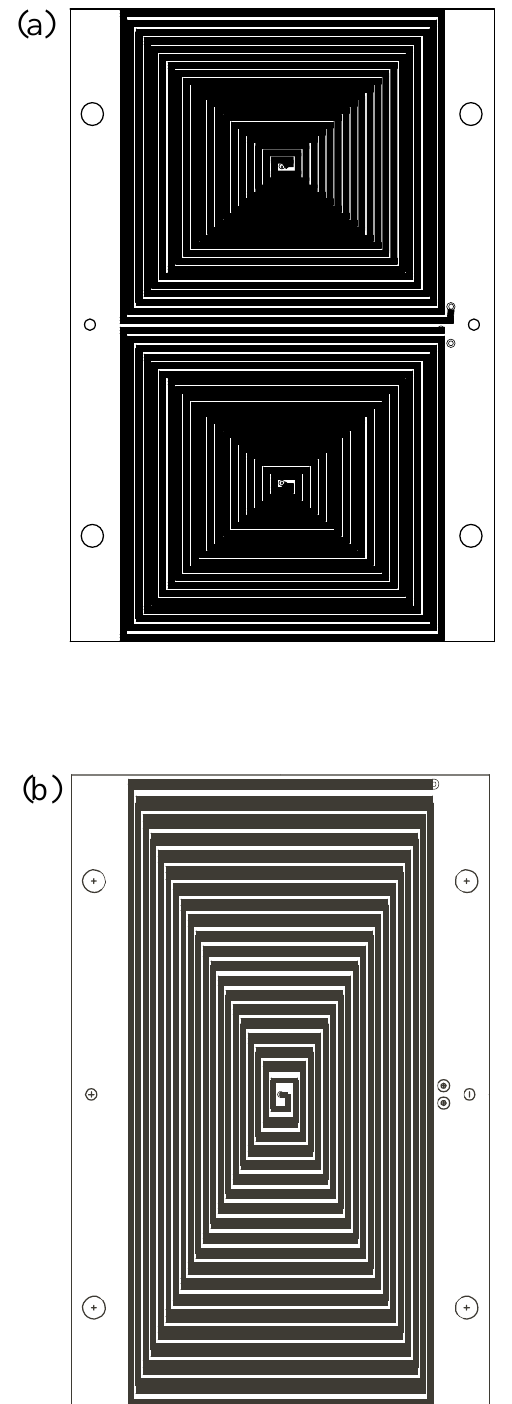
FIG. 3. Upper sides of the double-sided printed circuits that form one-half of the UMER quadrupole magnet (a) and dipole magnet (b) (to scale). The undersides of the circuits have similar patterns, with series connections and opposite rotation so that the fields are doubled and the field due to the external leads is minimized. The small holes near the edges in (a) and (b), in the middle, are used for alignment pins. The bigger holes are used for attaching the circuits to aluminum pieces as shown in Fig. 2(b) for the PC quadrupole.